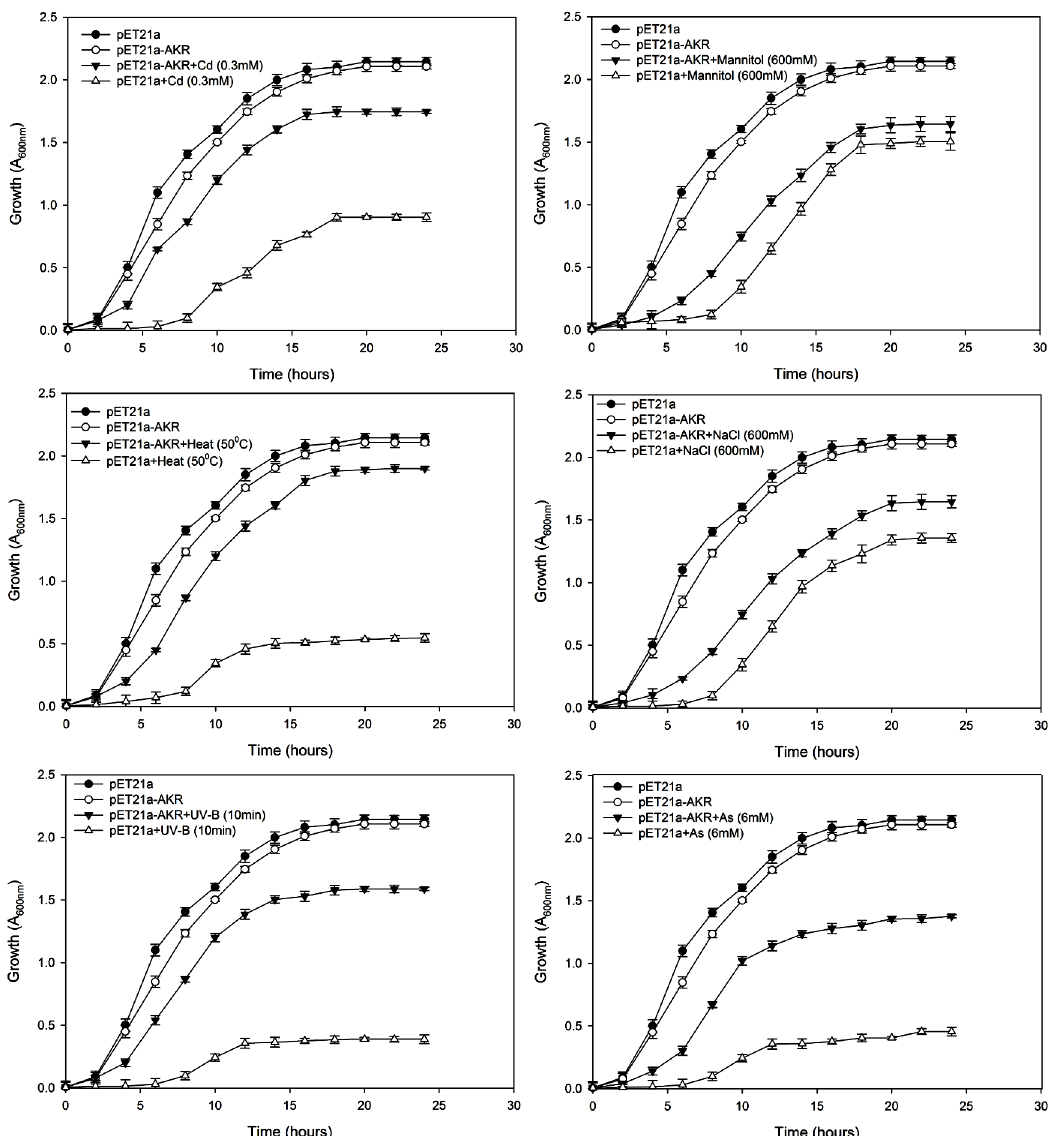
Fig 5. Growth behavior of E . coli BL21 (DE3) cells transformed with pET21a and pET21a-AKR in response to (a) cadmium (0.3 mM) (b) mannitol (600 mM), (c) heat (50°C), (d) NaCl (600 mM), (e) UV-B (10 min) and (f) arsenic (6 mM) stress using liquid culture assay. The mean of three independent replicates is plotted with error bars indicating standard deviations. (a-f) represents the growth curves of E . coli strains in LB medium supplemented with 100 μ g ml − 1 ampicillin and 0.2 mM IPTG.